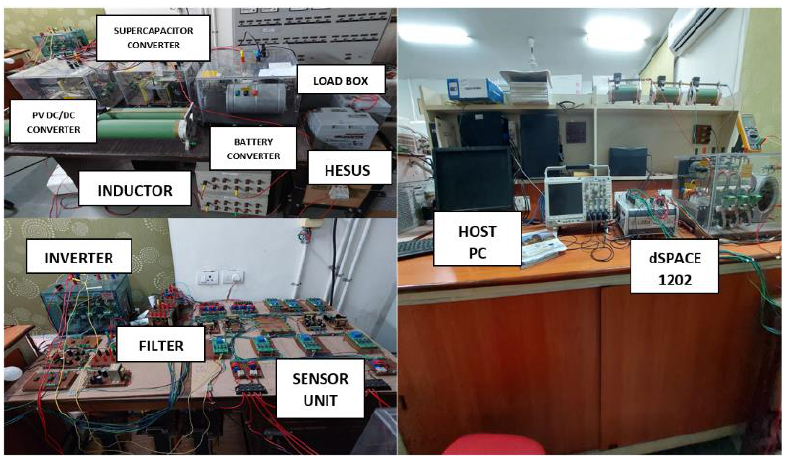
Figure 23. Experimental set-up .